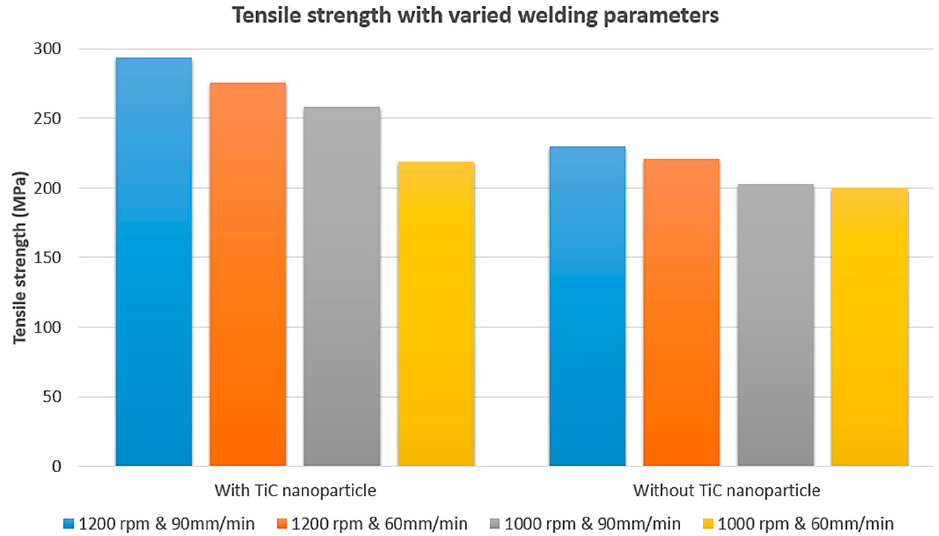
Figure 10. Joint tensile properties with TiC addition and variation in welding parameters. Table 1. FSW parameters variation influence on nanoparticles distribution and its AA6082 joint